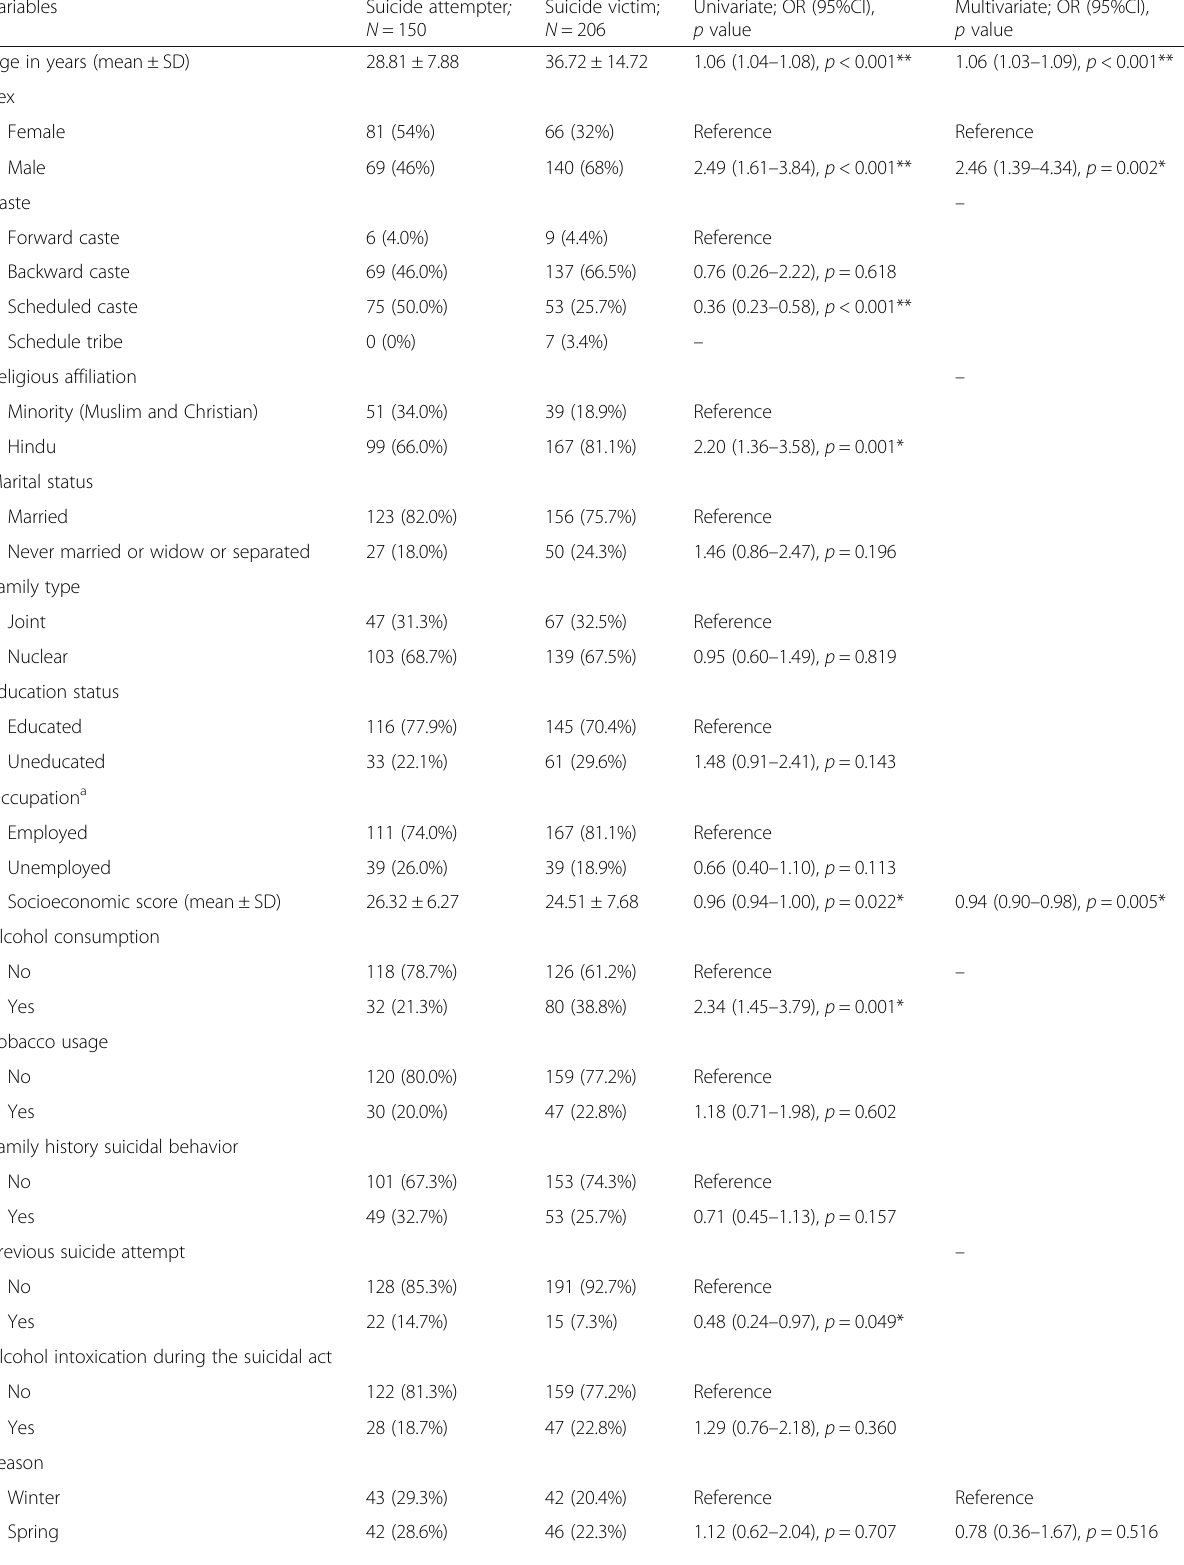
Table 1 Comparison of sociodemographic variables and suicide behavior